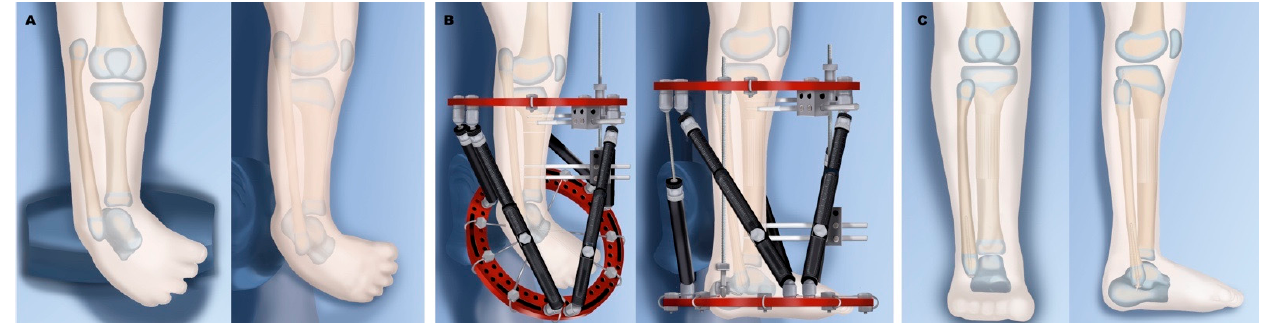
Figure 3. Treatment of Paley type 2A. ( A ) Typical deformity with shortened tibia and equinovarus foot and overgrown proximal fibula. ( B ) Application of external fixator for staged correction of foot equinovarus, distal fibular transport, and finally lengthening of the tibia. ( C ) Results after tibial lengthening with distal fibular screw epiphysiodesis.